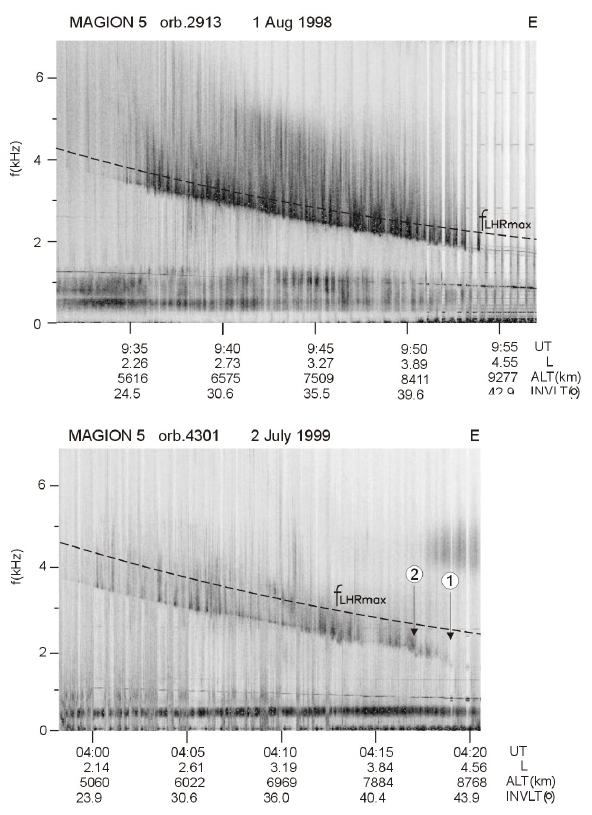
Fig. 6. VLF wave spectrograms from a short interval of the MA- GION 5 orbit No. 2913 (see Fig. 5, upper panel). Electric and mag- netic components are shown in the upper and lower panels, respec- tively. LHR noise band is observed in the E- component